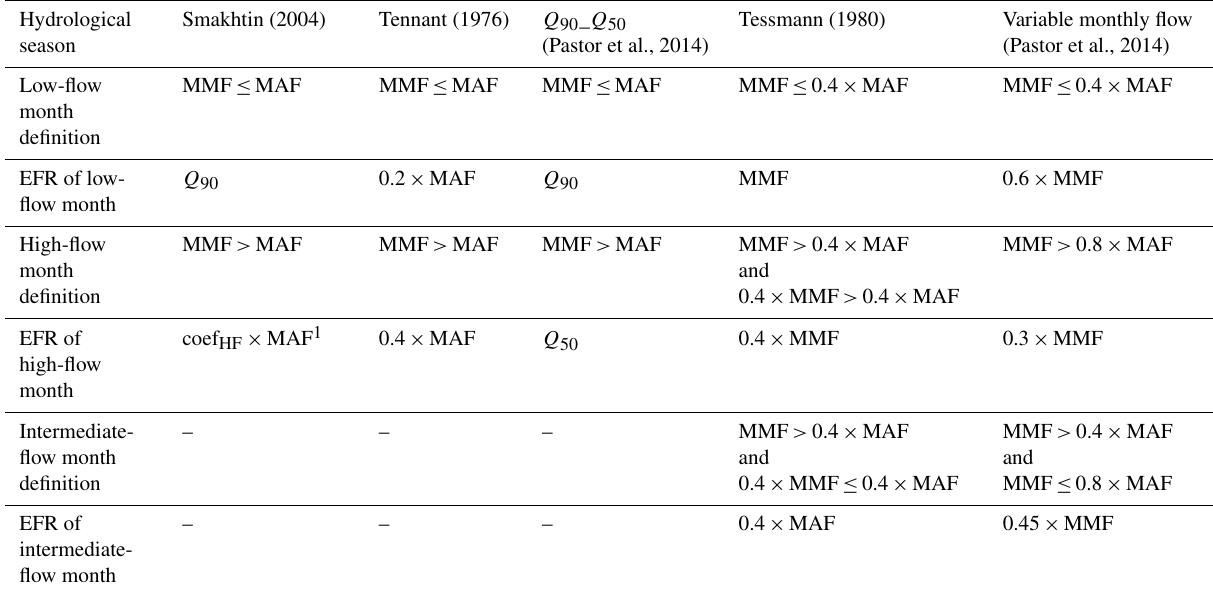
Table 1. Descriptions of hydrological EF methods used to calculate environmental flow requirements (EFRs) in this study (adapted from Pastor et al., 2014). MMF refers to mean monthly flow of each month, MAF to mean annual flow (the mean monthly flow of all months within a year), Q 50 and Q 90 to flow exceeding 50% and 90% of the flows during the period of interest respectively, and coefHF to high-flow coefficient used in Smakhtin’s